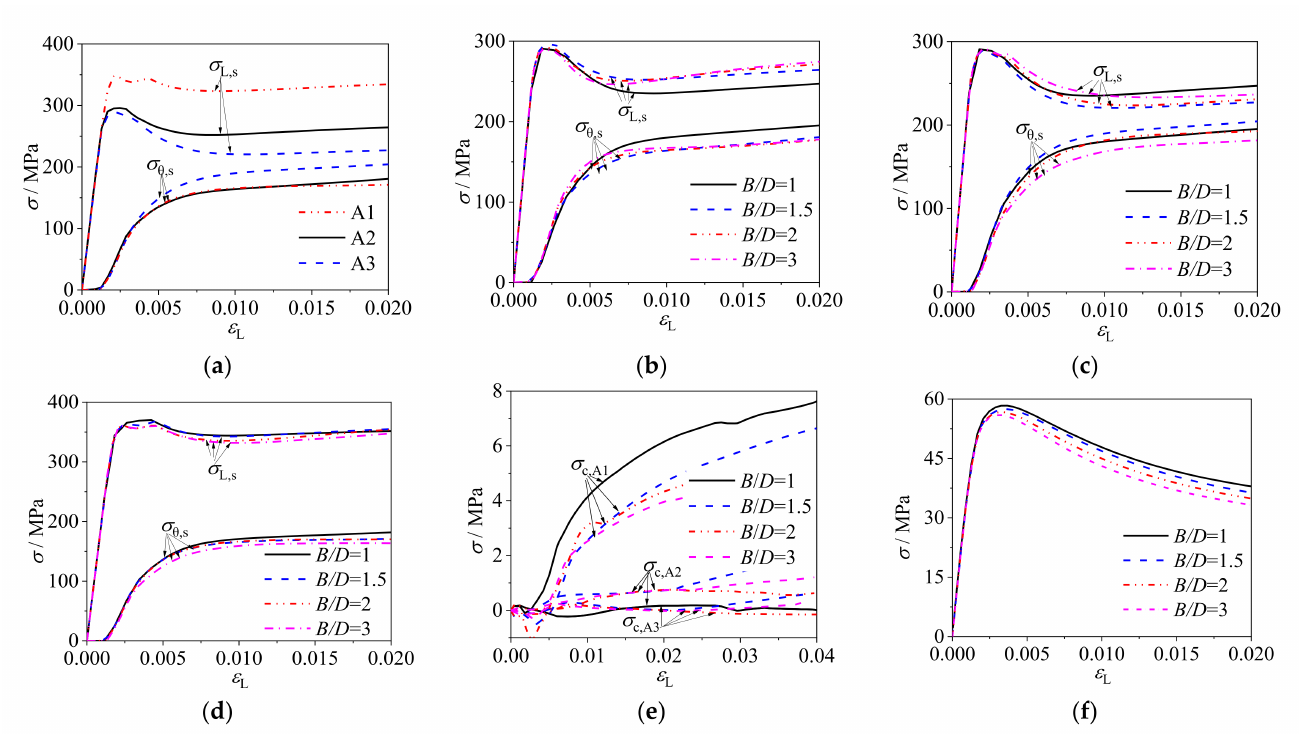
Figure 6. Stress–strain curves of rectangular CFCFST stub columns with different B / D : ( a ) stress–strain curves of steel tubes at different measuring points, ( b ) stress–strain curves of steel tubes at long-side midpoint A2, ( c ) stress–strain curves of steel tubes at short-side midpoint A3, ( d ) stress–strain curves of steel tubes at endpoint A1, ( e ) radial stress–strain curves of core concrete, and ( f ) average axial stress of core